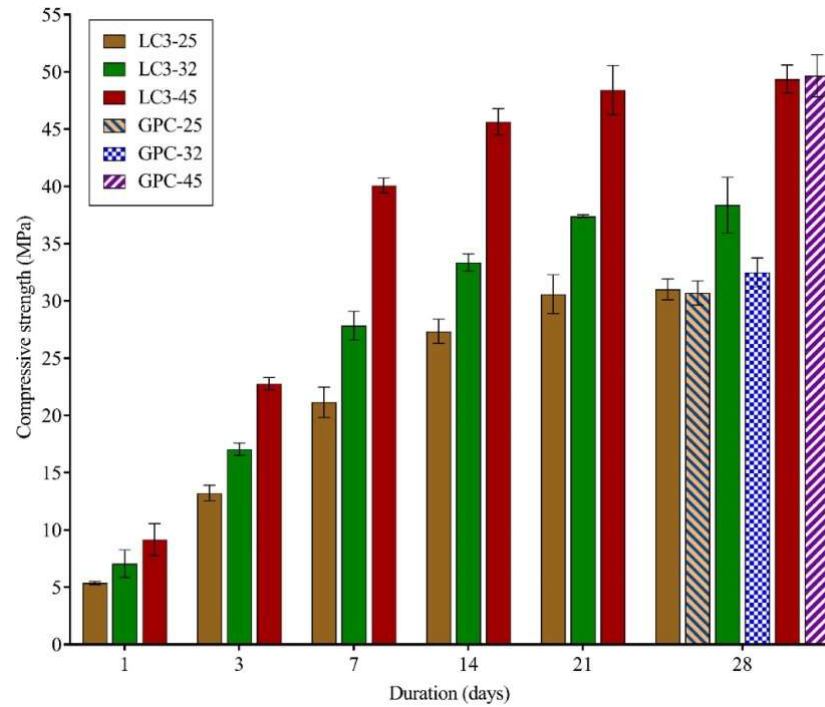
Figure 10. Compressive strength of LC 3 and GPC concrete [75].